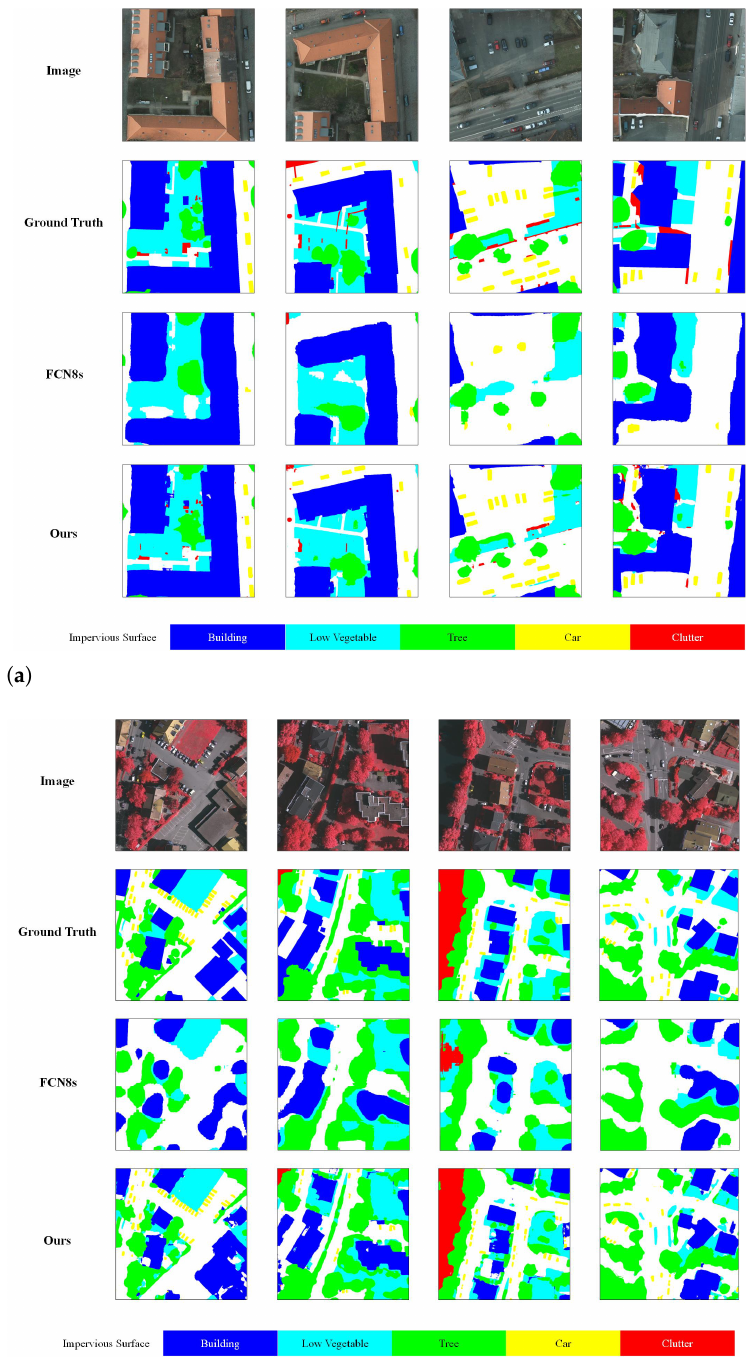
Figure 10. Segmentation results on the two datasets using the slide inference strategy. The result are cropped from the original image prediction: ( a ) 1000 × 1000 segmentation results on the Potsdam dataset; ( b ) 1000 × 1000 segmentation results on the Vaihingen